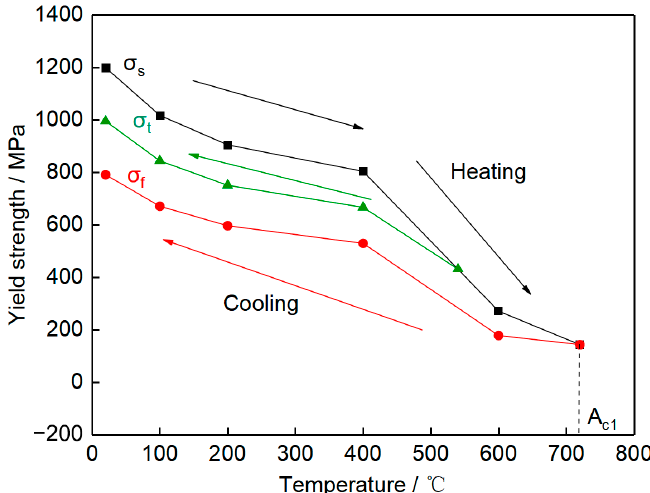
Figure 9. Softening